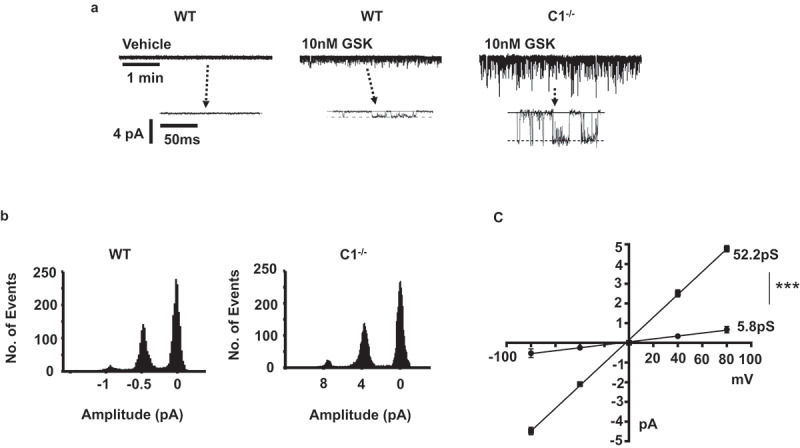
GSK1016790A-evoked cation channel currents in WT and TRPC1-/- ECs.(a) Application of GSK1016790A (GSK) in the patch pipette solution activated cation channel activity in cell-attached patches held at −80 mV from WT and TRPC1-/- ECs, with single channel current amplitudes being much greater in TRPC1-/- ECs. (b) Representative amplitude histograms of GSK-induced single channel activity from WT and TRPC1-/- ECs. Amplitude histograms had 3 identifiable peaks representing one closed (0 pA) and two unitary amplitude levels, namely ~-0.5 pA and −1pA in the WT patch vs. ~- 4pA and −8pA in the TRPC1-/- EC patch. Given these values are multiples of each other it is likely that the respective patches contained at least 2 channels. (c) Mean pooled current/voltage relationships of GSK-evoked cation channel activities in WT and TRPC1-/- ECs, which had unitary conductances of 5.8pS and 52.2pS respectively, and similar extrapolated reversal potentials of about 0 mV. Each data set is from at least n = 6 patches, from at least N = 5 animals, ***p < 0.001, 2-way ANOVA.